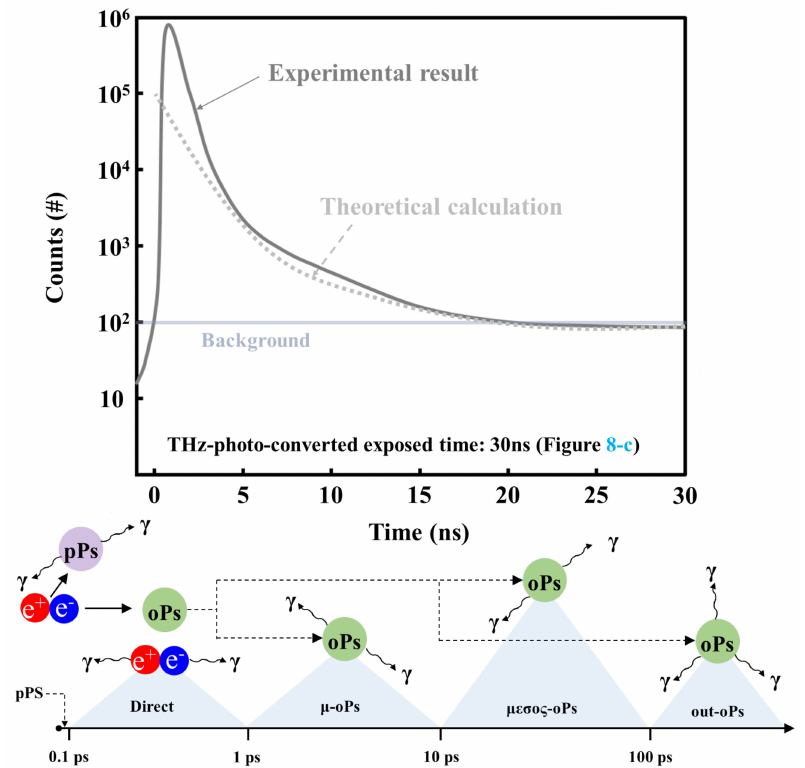
Figure 10. Lifetime of Ps in the air-saturated sample (a semilog histogram of the time lag between the start and stop signals from the air-saturated sample whose slope was fitted with a single exponential function (theoretical calculation) and a flat background (background) to determine the o-Ps lifetime; the detailed fit range was from 0.1 ns to 100